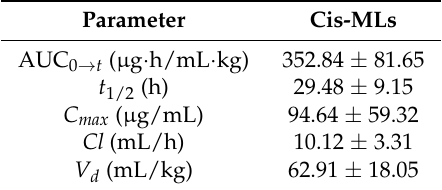
Table 3. Pharmacokinetic parameters of iron after intravenous administration of Cis-MLs ( n = 6).